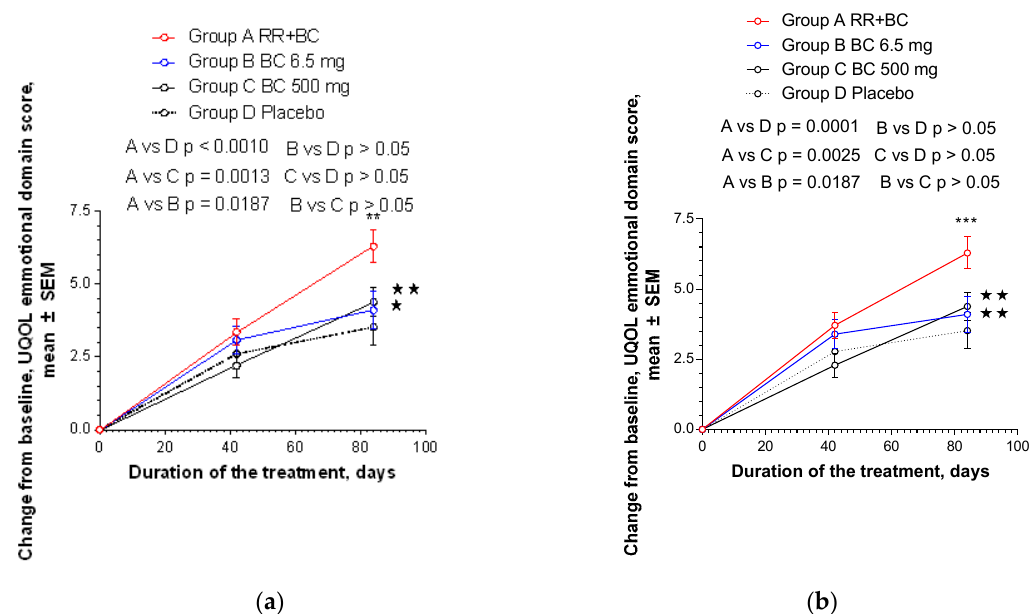
Figure A5. The change from baseline of menopause UQOL emotional domain scores (mean ± SD) over time: ( a ) -ITT analysis, ( b ) -PP analysis. Significance of difference between groups at various time points, calculated by Bonferroni post-test, is expressed by ** p < 0.01, *** p < 0.001; ns: not significant (A, B, C vs. placebo) and * p < 0.05 (B vs. A), ** p < 0.001 (B and C vs. A).